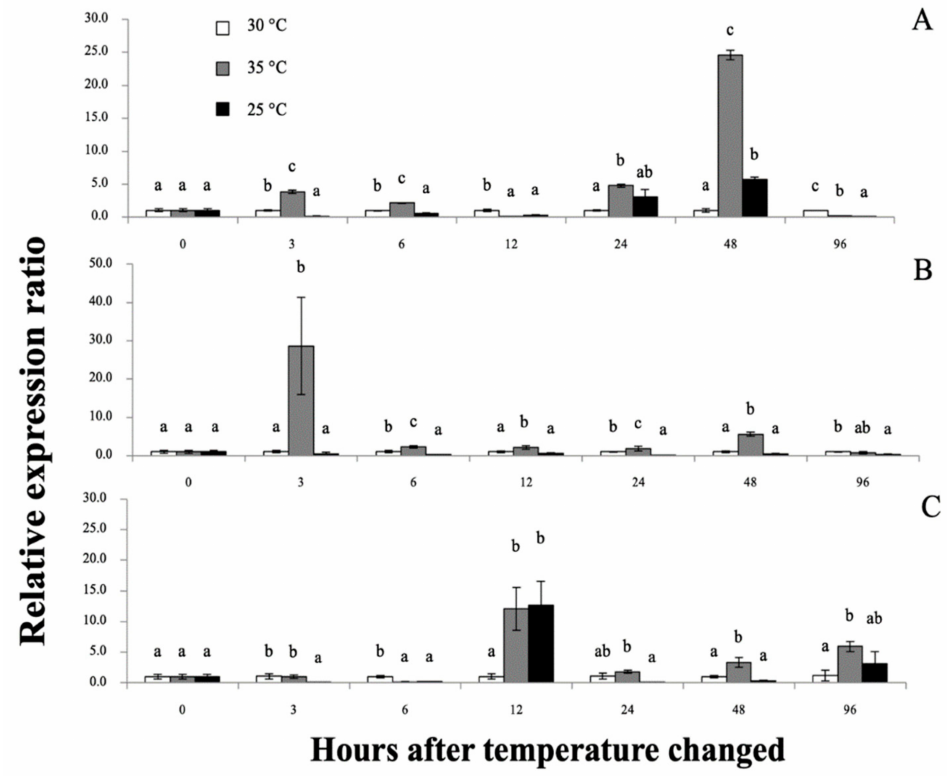
Figure 12. The Mr-hsp90 mRNA expression levels relative to β -actin levels analyzed by qRT-PCR in the gills ( A ), hepatopancreas ( B ) and hemocytes ( C ) of giant river prawns after induction with temperatures at 30, 35 and 25 ◦ C. Data with different letters (a, b and c) were significantly different ( p < 0.05) at the same exposure